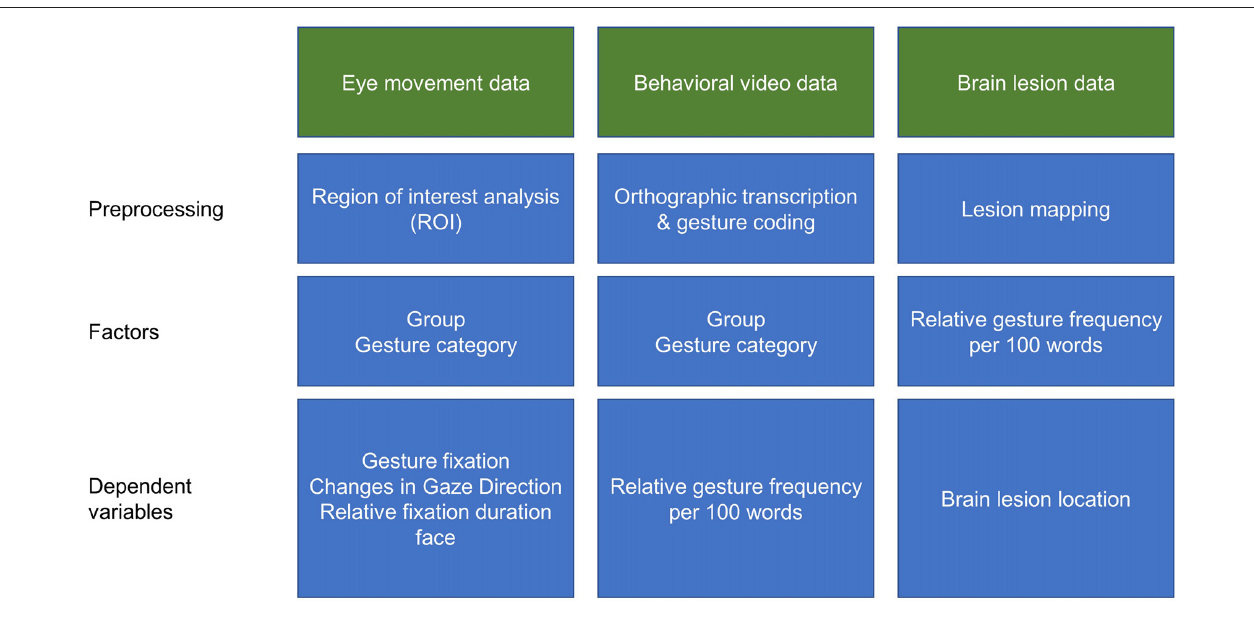
FIGURE 1 | Schematic illustration of the data analyses